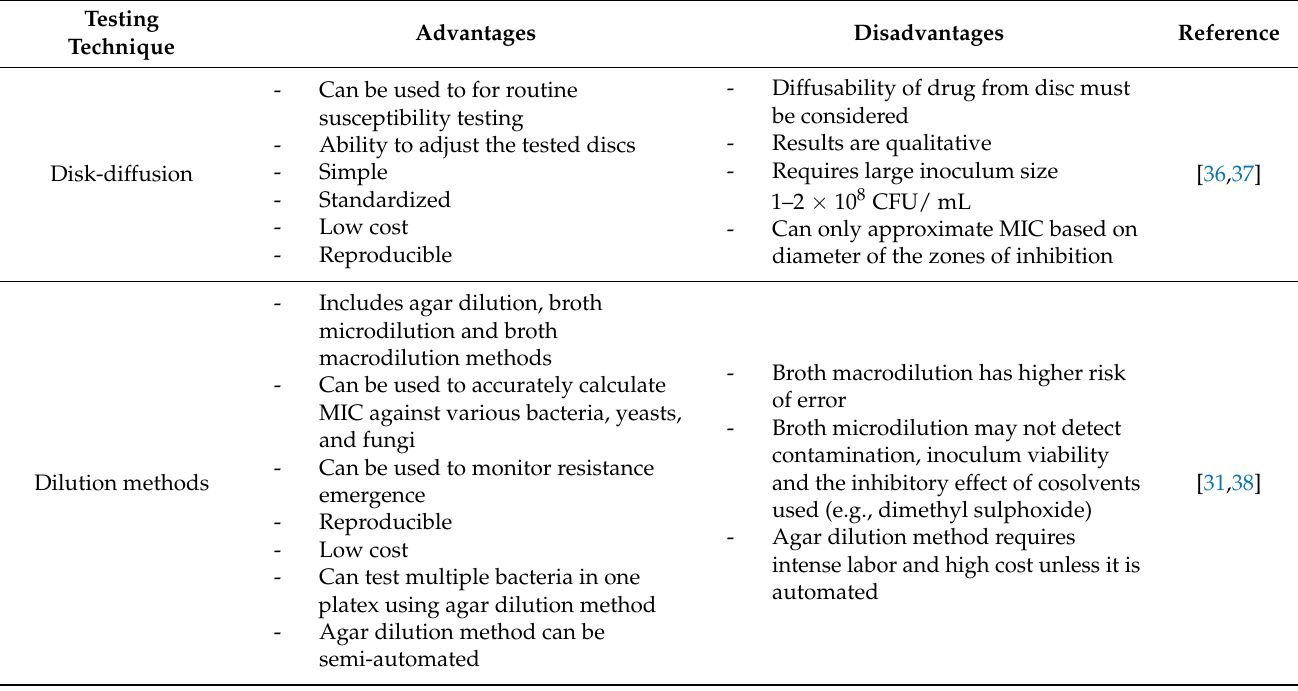
Table 2. Advantages and disadvantages of commonly applied technique for the evaluation of drugs antimicrobial